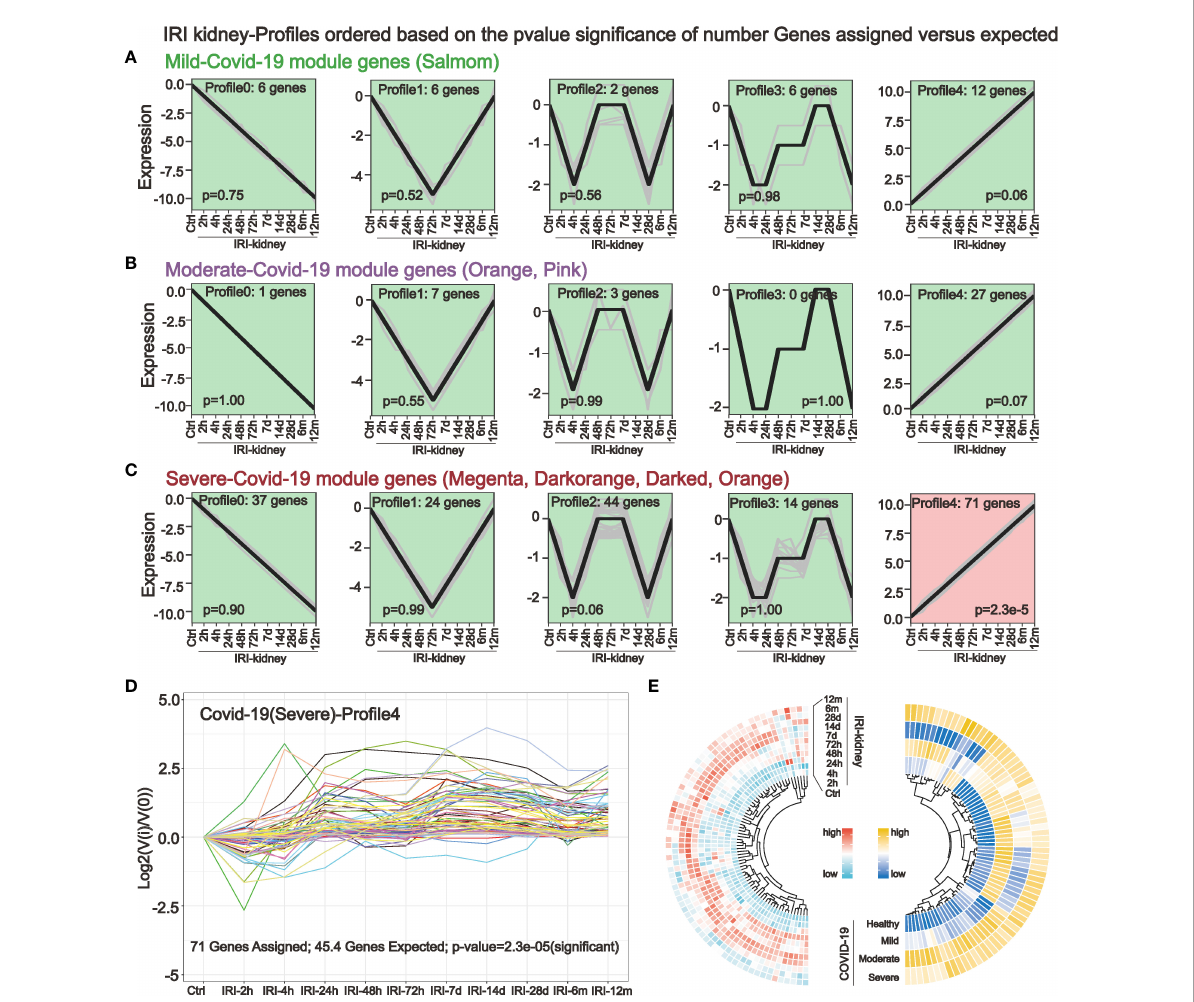
FIGURE 3 Short-time sequence expression miner (STEM) identi fi es genes associated with the progression of kidney injury in different COVID-19 stages. (A – C) STEM analysis was performed in a dataset with consecutive time points of IRI kidney injury by using key genes of mild (A) moderate (B) and severe (C) COVID-19. Five different gene expression pro fi les were simulated to identify genes that are altered in parallel with COVID-19 in the IRI kidney. (D, E) STEM analysis revealed that only in severe COVID-19, a small cluster of key genes was associated with IRI kidney injury (D) . These 71 genes had the same expression trend and were elevated after 24h of IRI, with some genes persistently highly expressed in the subsequent IRI time points (E) , these genes are potentially highly correlated with COVID-19 renal